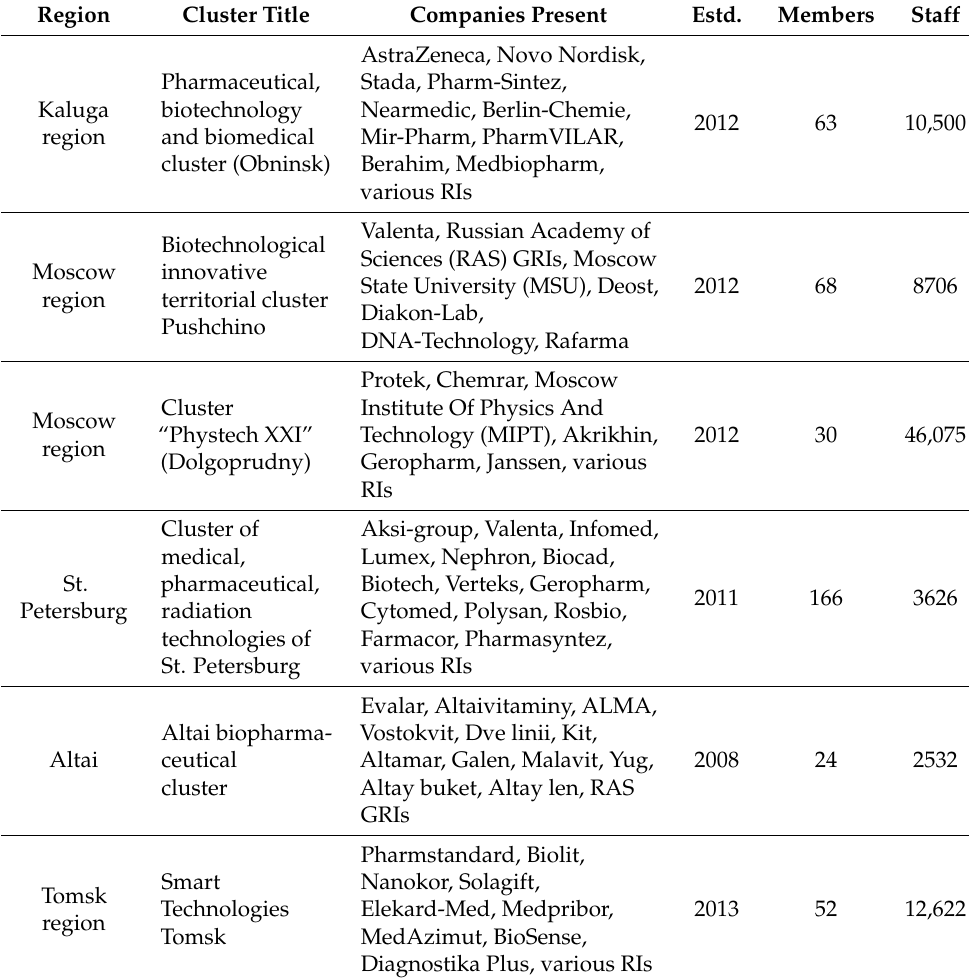
Table 1. Russia’s pharmaceutical